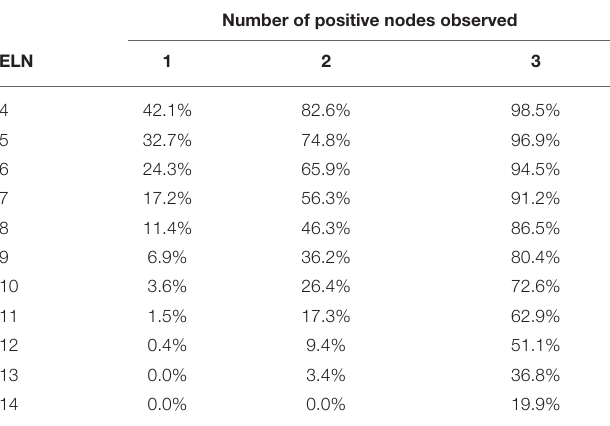
TABLE 6 | Probability of 4 or more positive lymph nodes in patients with T2 tumor.